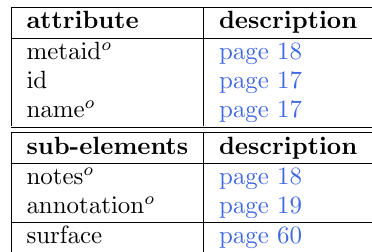
Table 2.26: Attributes and nested elements for plot3D. xy o denotes optional elements and attributes.